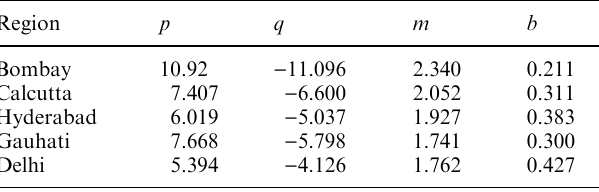
Table A1. Parameters of fitted log-normal distributions for the height H (km) of cumuli estimated from p and q (hot season) Region p